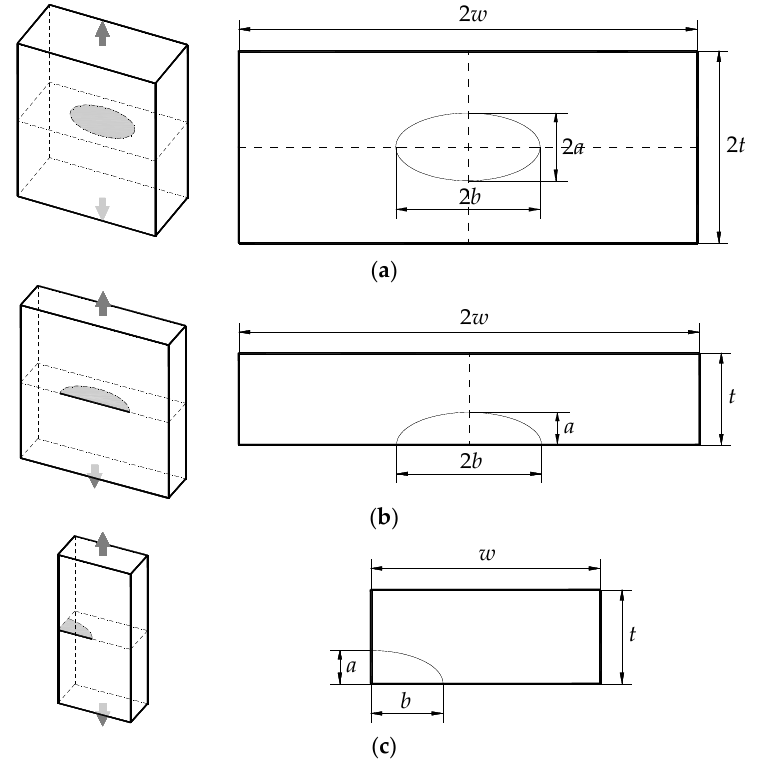
Figure 1. Scheme of a finite-thickness plate with: ( a ) an elliptical embedded crack; ( b ) a semi-elliptical surface crack; ( c ) a quarter-elliptical corner crack.